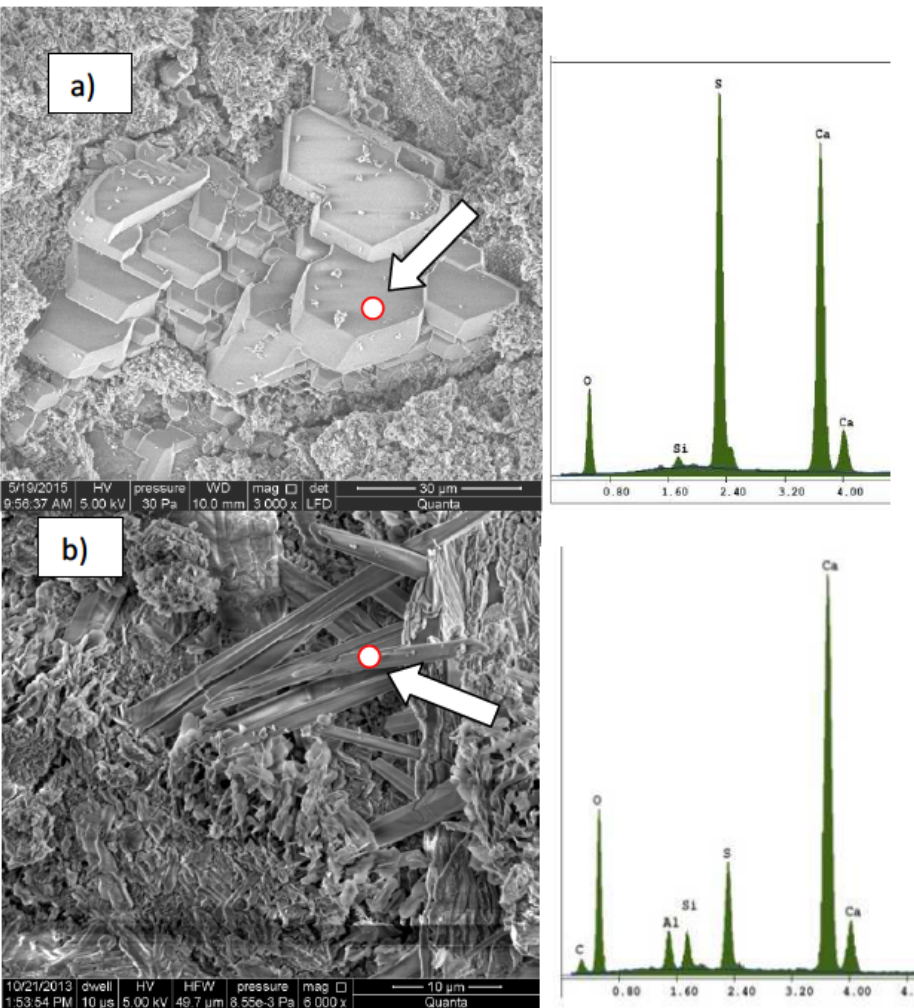
Figure 6: Gypsum (a) and ettringite (b) in mortars in which 20% cement was replaced by LCFA immersed with 5% Na 2 SO 4 with analysis of the chemical composition at